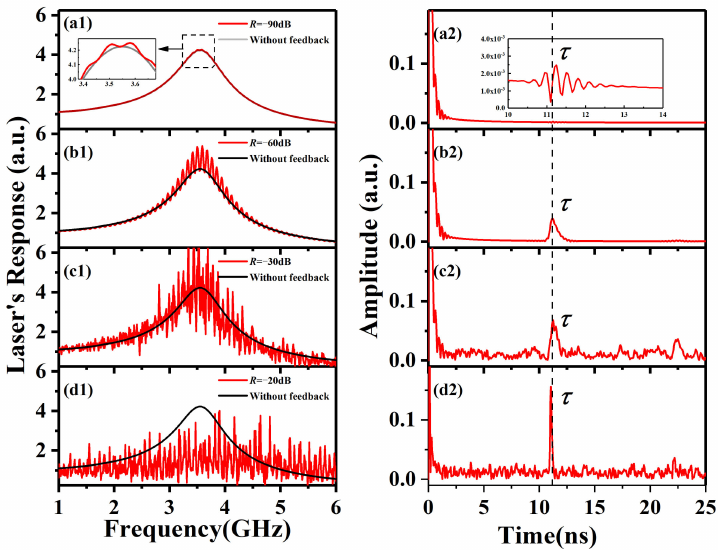
Figure 2. Typical results of frequency-resonance method with laser running at 2 I th with different feedback strength R . ( a1 , b1 , c1 , d1 ) the modulation response curves and ( a2 , b2 , c2 , d2 ) IFT curves when R is − 90 dB, − 60 dB, − 30 dB, and − 20 dB,